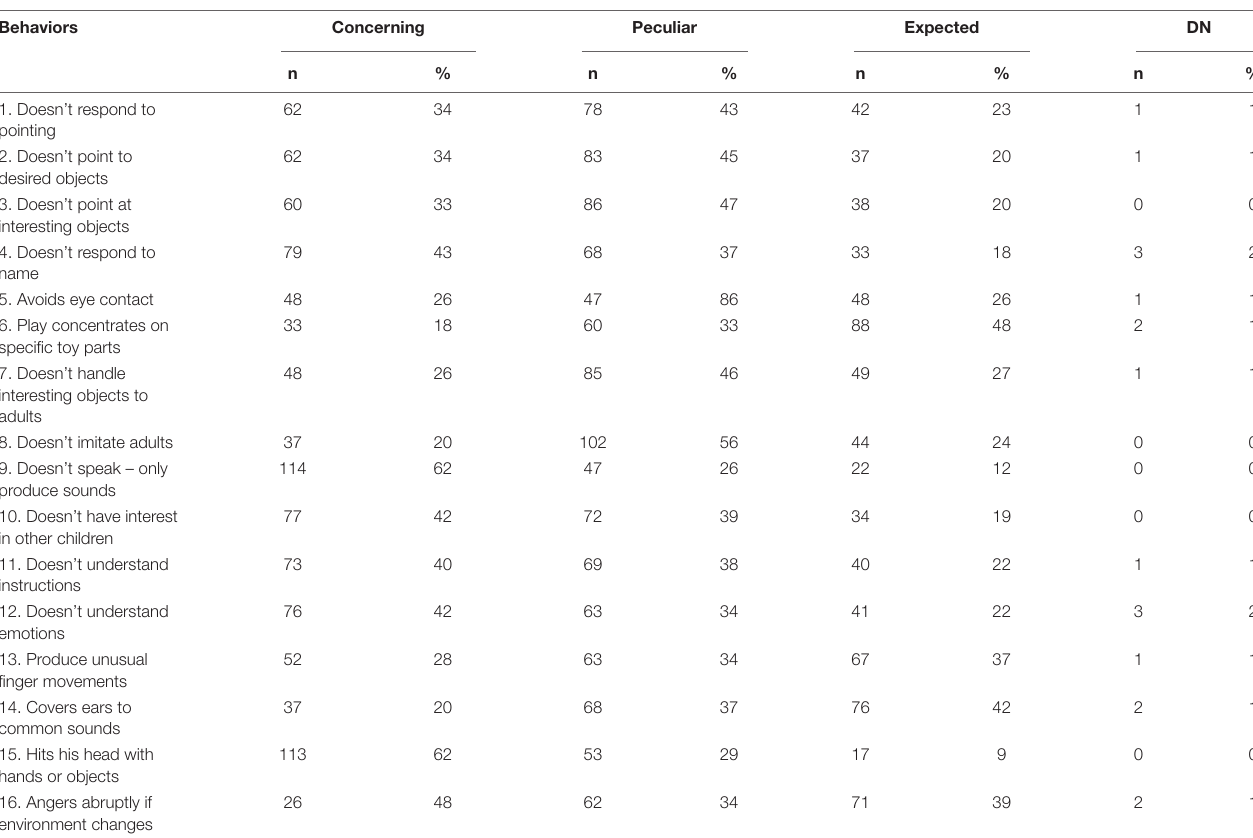
TABLE 2 | Perception of the degree of concern by 183 adults in % in function of 16 behaviors. Behaviors Concerning Peculiar